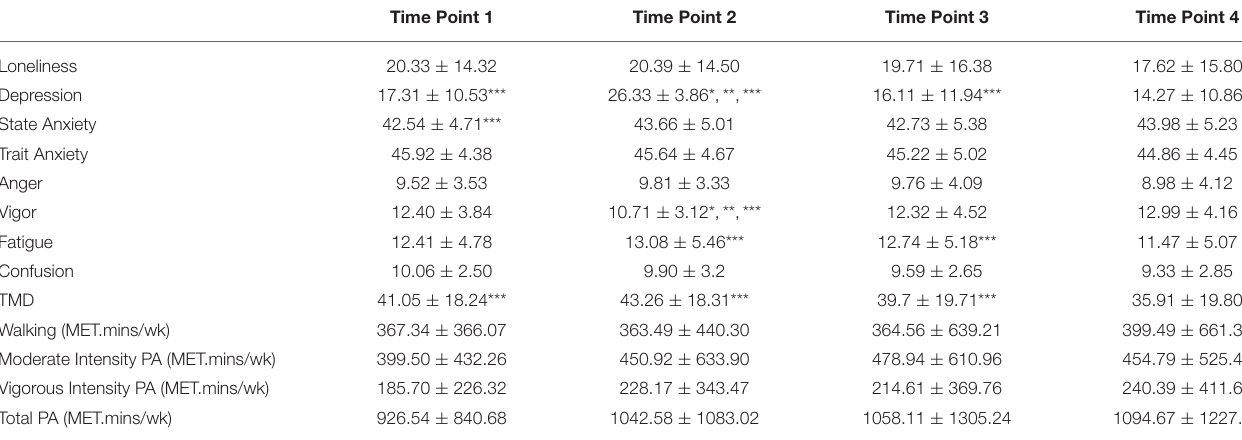
TABLE 2 | Descriptive Statistics examining differences in mental health outcomes and physical activity amount over four time